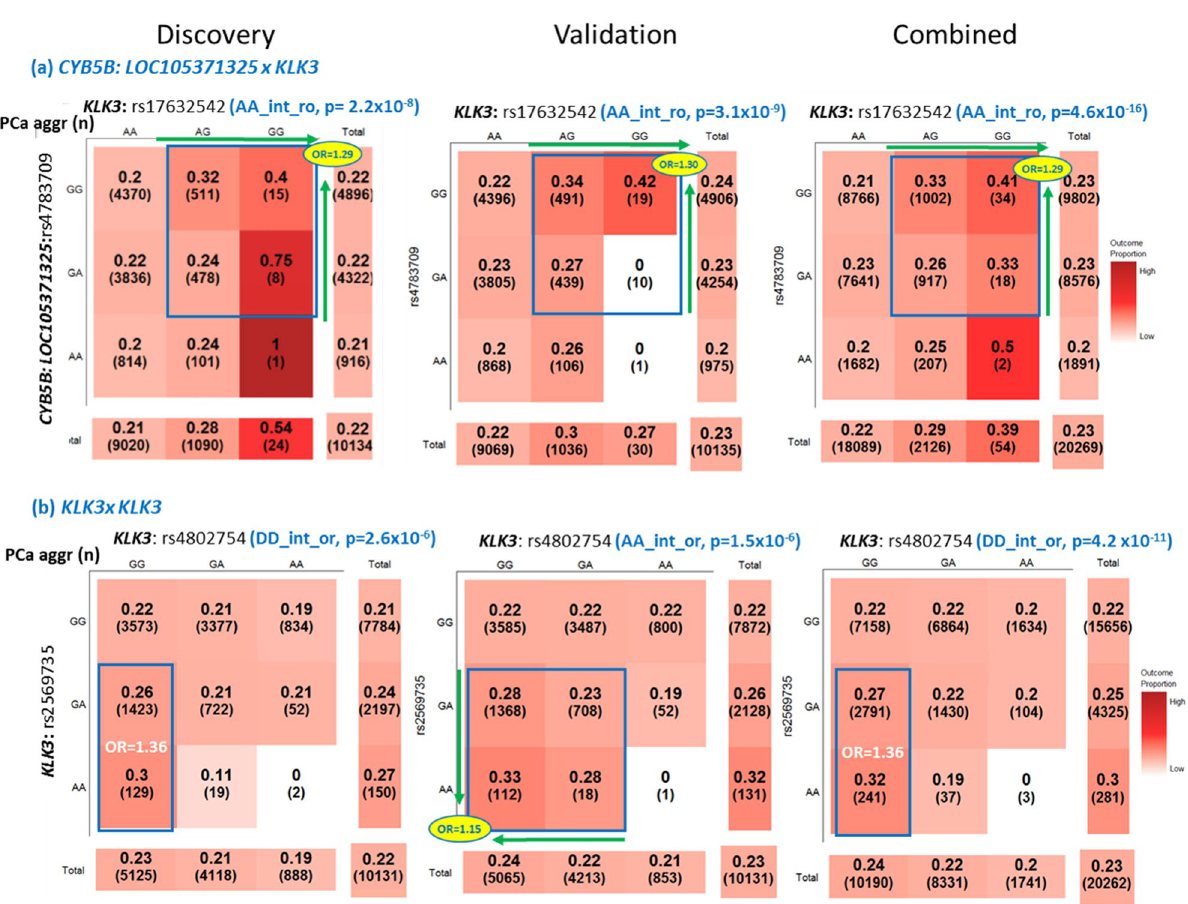
Figure 2. Selected SNP–SNP interactions associated with prostate cancer aggressiveness. PCa aggr (n): prevalence of prostate cancer aggressiveness (sample size in the genotype combination); SNP–SNP Interaction Pattern: “(SNP1 mode)(SNP2 mode) _int_ (SNP1 code)(SNP2 code)”; OR of PCa aggressiveness adjusted for study sites and six principal components for population stratification. The darker color indicates a higher chance of prostate cancer aggressiveness. A additive inheritance modes, aggr aggressiveness, D dominant inheritance modes, o original coding based on the minor allele, OR odds ratio, PCa prostate cancer, R recessive inheritance modes, r reverse code direction, SNP single-nucleotide polymorphism. These heat tables were generated using the plot3by3 function in the SIPI R